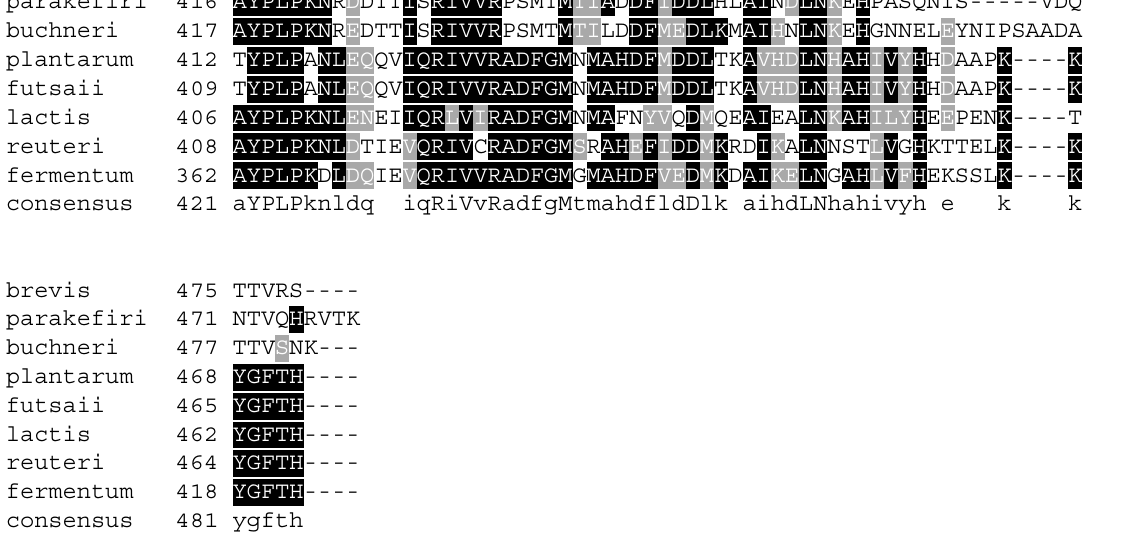
Table 2. Biochemical properties of glutamate decarboxylase from various LAB.